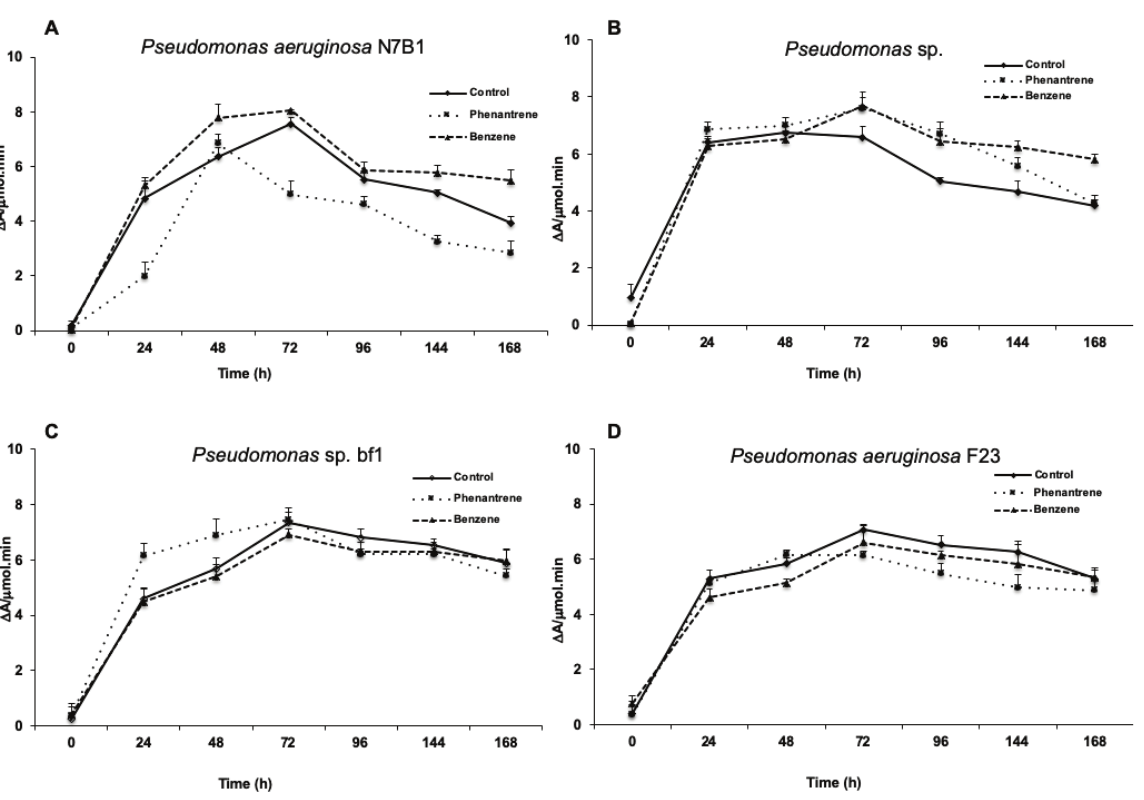
Figure 2: Polyphenol oxidase activity in cell-free extracts of Pseudomonas strains grown in BHB medium at 500 ppm phenanthrene and 1000 ppm benzene concentrations. A) Pseudomonas aeruginosa N7B1, B) Pseudomonas sp., C) Pseudomonas sp bf1, and D) Pseudomonas aeruginosa